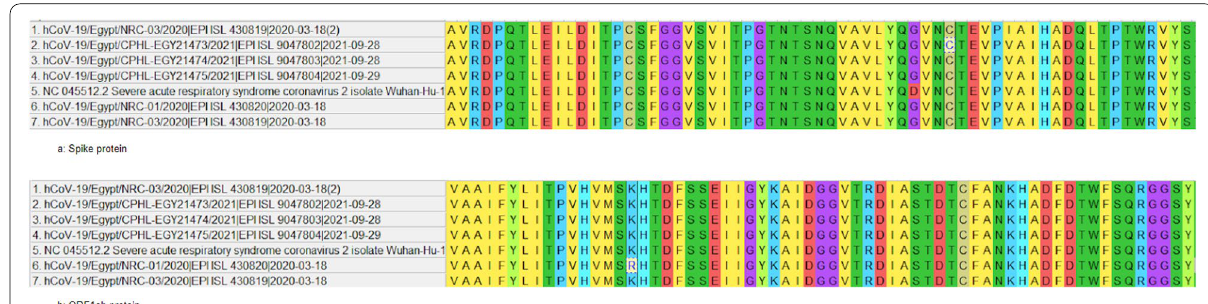
Fig. 3 Multiple sequence alignment of both a Spike and b ORF1ab proteins of SARS‑CoV‑2 in Wuhan and in Egypt